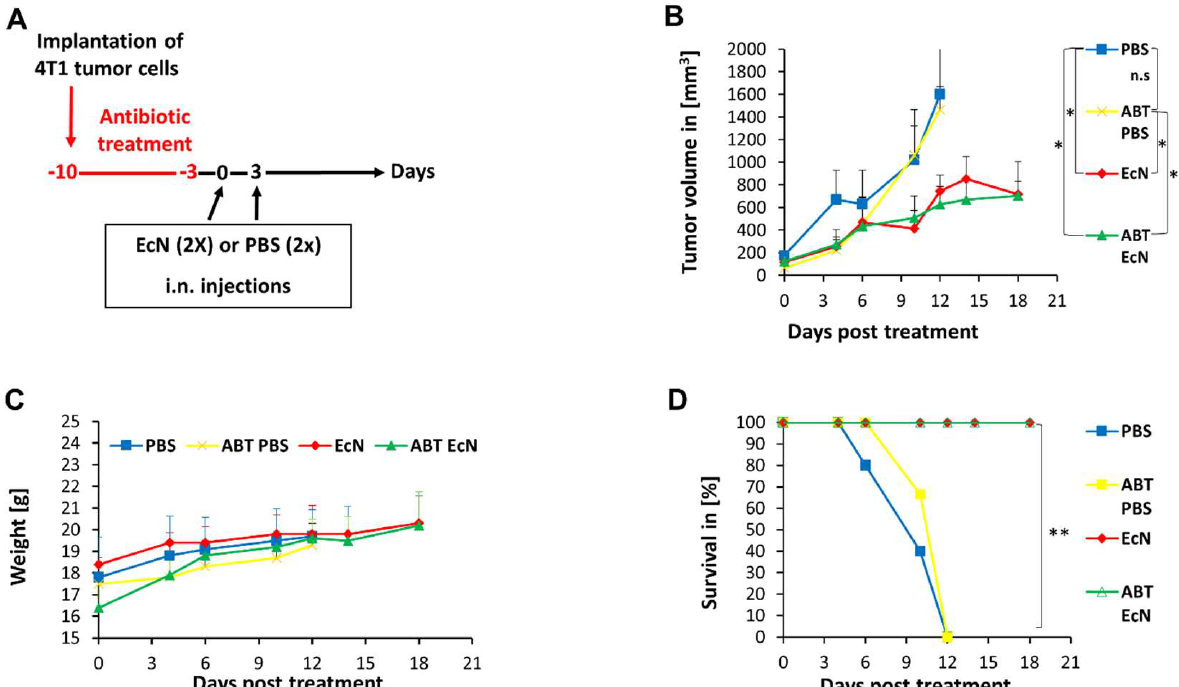
Figure 2. ( A ) Schedule of tumor implantation, antibiotic-induced microbiome depletion and EcN/pMUT-gfp Kn r (EcN)-mediated tumor therapy in 4T1 tumor-bearing BALB/c mice. ( B ) Effects of intranasal bacterium or PBS injections on tumor growth of 4T1 tumor-bearing BALB/c mice with and without pretreatment with antibiotic (ABT). PBS —PBS-injected group; ABT PBS —antibiotic- pretreated and PBS-injected group; EcN —EcN/pMUT-gfp Kn r injected group; ABT EcN —antibiotic- pretreated and EcN/pMUT-gfp Kn r injected group. Results are displayed as means +/ − standard deviation. The statistical significance was calculated by the Student’s t -test where * indicates p < 0.05 and “ns” indicates not significant. ( C ) Effect of different treatments on weight of 4T1 tumor-bearing BALB/c mice. ( D ) Survival of 4T1 tumor-bearing BALB/c mice after intranasal EcN/pMUT-gfp Kn r or PBS treatment. The comparison of the survival between the three different treated groups was statistically evaluated by Kaplan–Meier and log-rank (Mantel-Cox) tests (GraphPad Prism, San Diego, CA). p < 0.05 was considered statistically significant. ** indicates p < 0.01. Table 4. CFU of EcN/pMUT-gfp Kn r (EcN) in tumor tissues of 4T1BALB/c mice at 18 dpbi. Mouse No. Group 1/Antibiotics pretreated